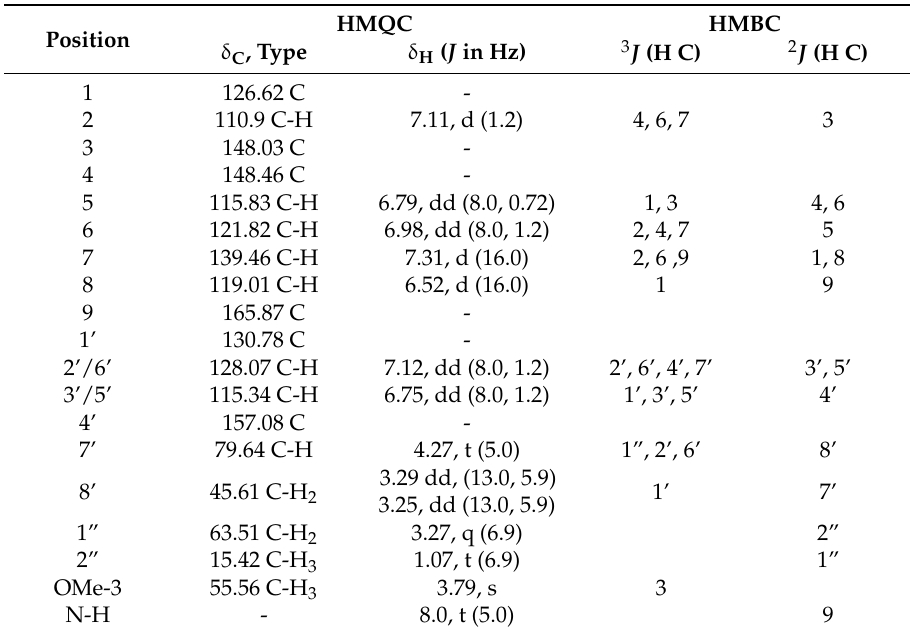
Table 1. 13 C-NMR (100 MHz), 1 H-NMR (400 MHz), HMQC and HMBC data of 7’-ethoxy- trans - feruloyltyramine ( 9 ) (DMSO- d 6 , δ